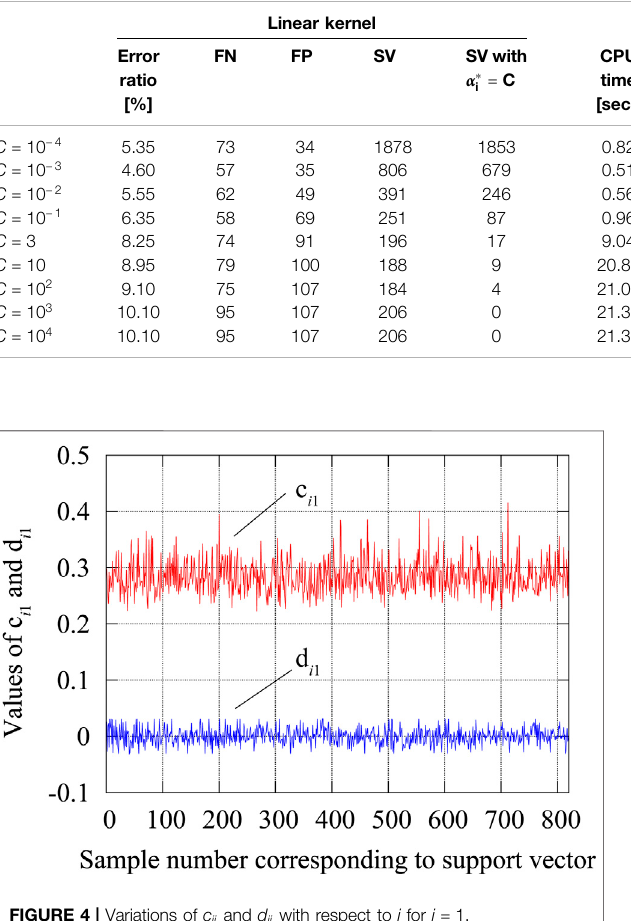
FIGURE 4 | Variations of c ij and d ij with respect to i for j (cid:2) 1.